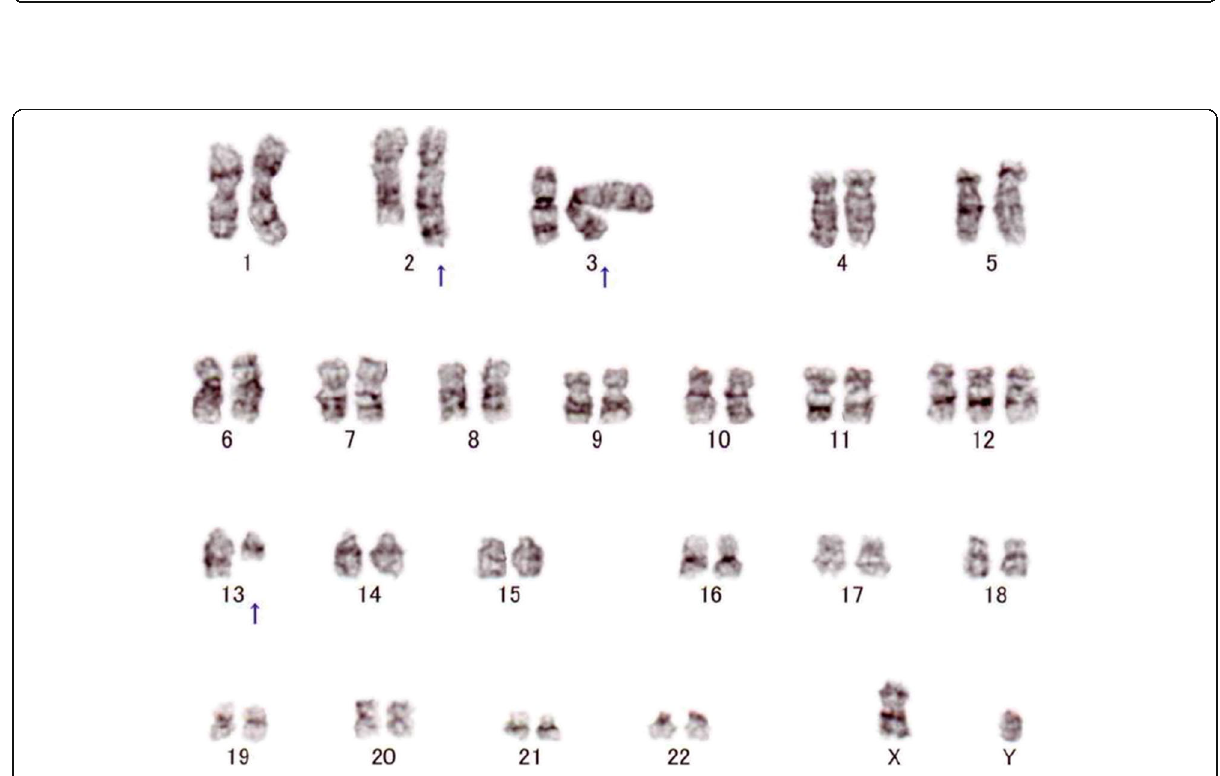
Fig. 6 Chromosomal analysis of bone marrow cells. A karyotype of bone marrow cells revealed translocation of (2;13)(q35;q14) in 14 among 20 analyzed